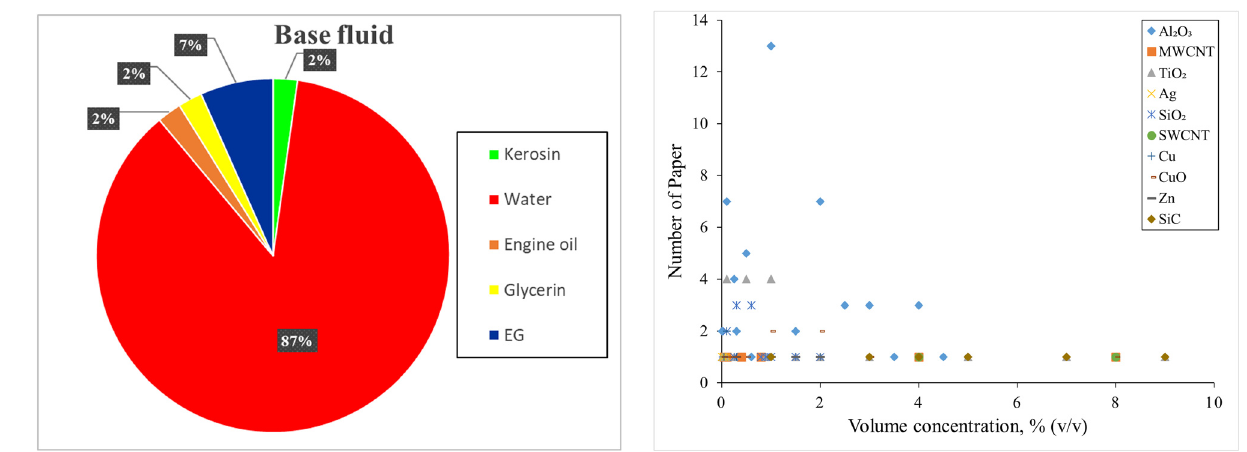
Figure 3: Type of base fl uids commonly used in nano fl uid preparation.